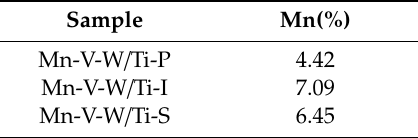
Figure 4. TEM image of the catalyst ( a – c ), the dispersion of Mn in the catalyst measured by EDS ( d – f ). Table 1. X Ray Fluorescence of the catalyst.